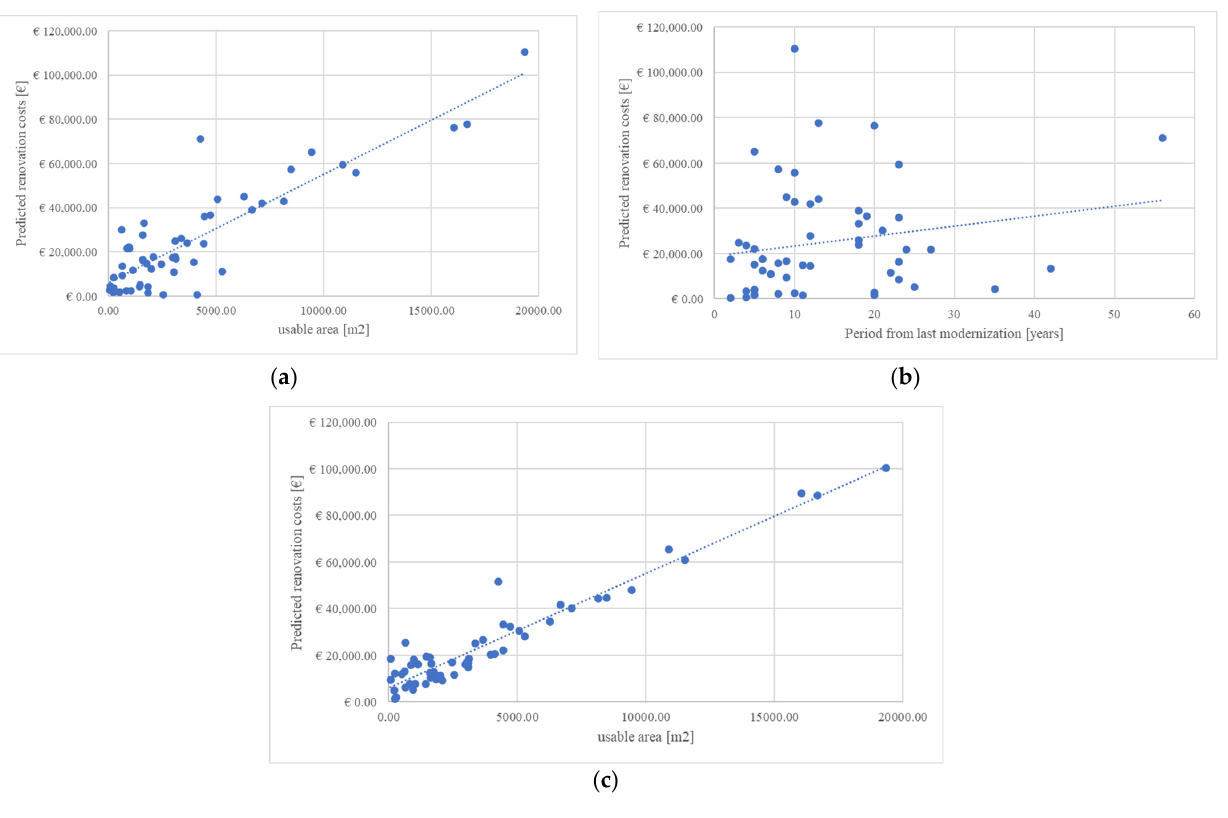
Figure 6. Predicted renovation costs: ( a ) in relation to the last modernization period (in years), ( b ) in relation to the usable area (m 2 ), and ( c ) based on independent variables.